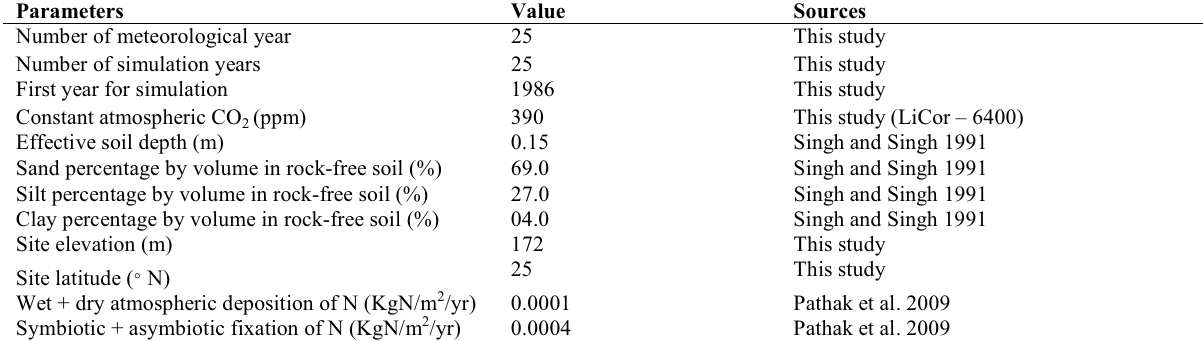
Table 2: Model input parameters for site